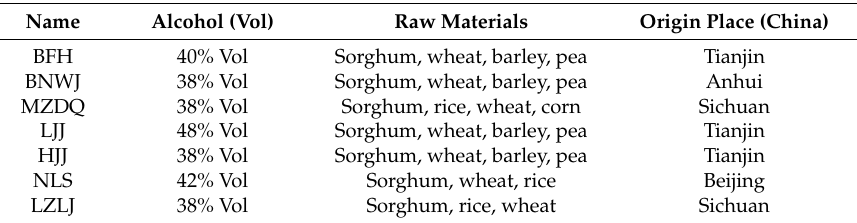
Table 1. Sample information of experimental liquors.